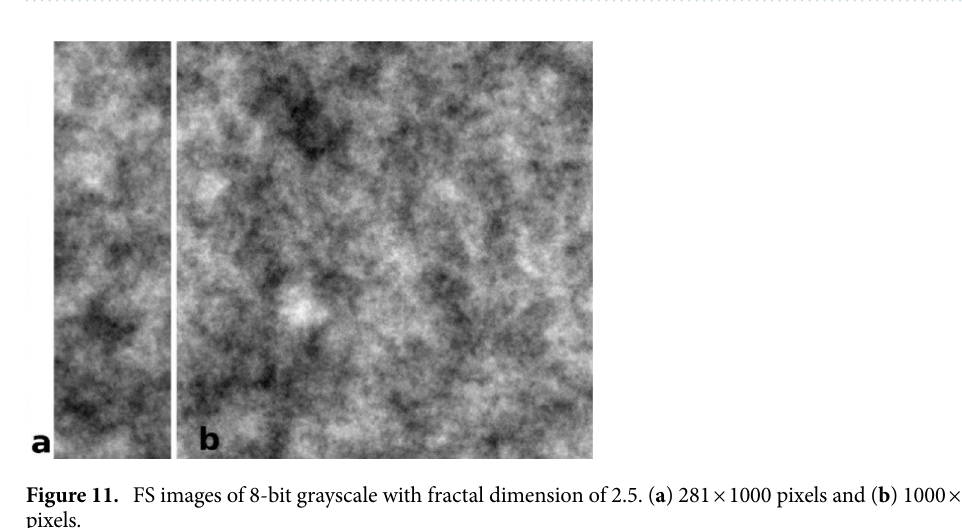
Figure 10. FS images of 8-bit grayscale applying the FFT algorithm and fractal dimension between 2.0 and 3.0.